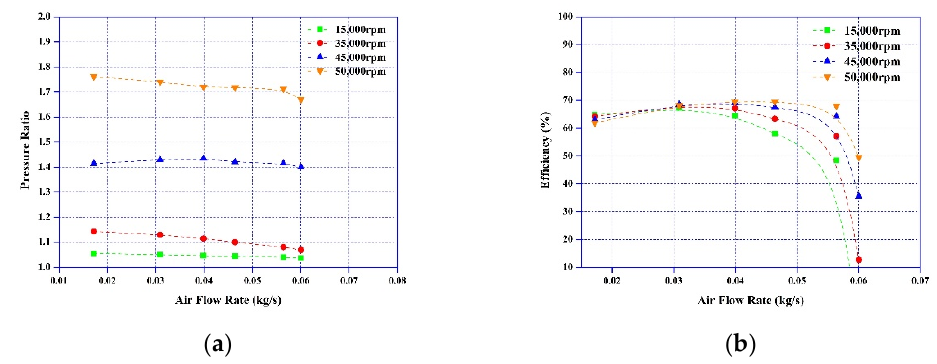
Figure 2. Characteristic performance of air blower with respect to motor speed ( a )—performance P-Q curve, ( b )—blower efficiency.